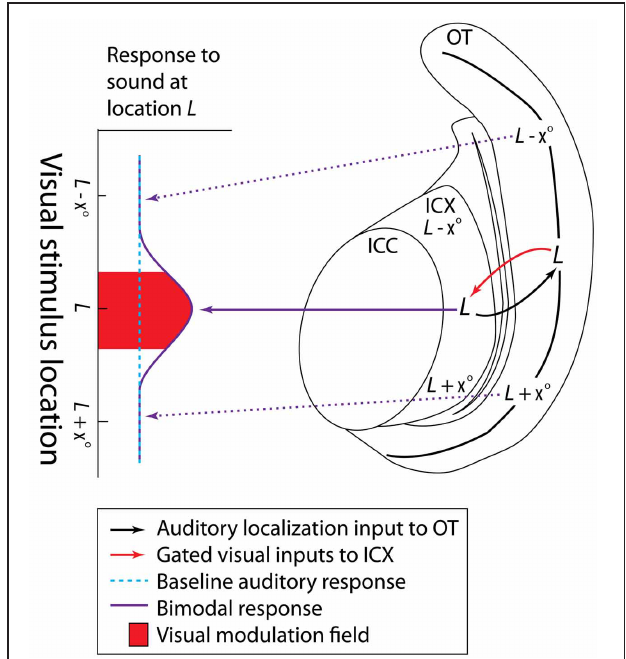
FIGURE 3 | Visual information modulates activity of cells in the owl ICX when auditory and visual inputs are closely aligned in space. Cells in the owl ICX respond best to a sound from some fixed location L in space (determined by interaural timing and level cues) (dotted blue line; note that the location of the auditory stimulus does not change in this schematic) and that information is transmitted to the corresponding location within the OT (black arrow). When a visual cue occupies the same or some nearby location in space, gated feedback from the OT (red arrow) enhances auditory responses (solid purple arrow); visual cues at other locations will not enhance auditory responses (dotted purple arrows). The visual field corresponding to ≥ 50% of the max auditory modulation is defined as the visual modulation field (red field). Adapted from Gutfreund et al. (2002); and Bergan and Knudsen